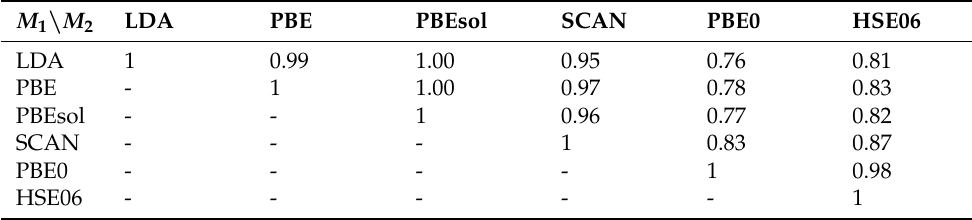
Table 2. Rank correlation matrix between error